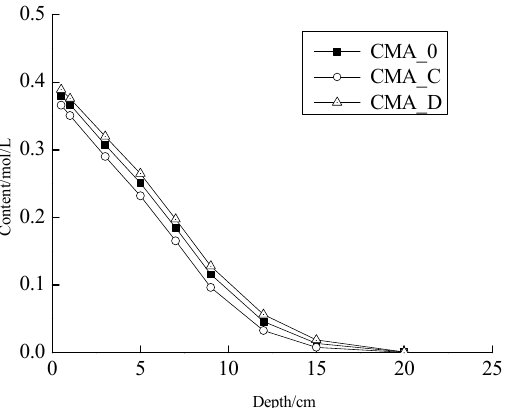
Figure 13. The relationship between chloride ion concentration and the depth.